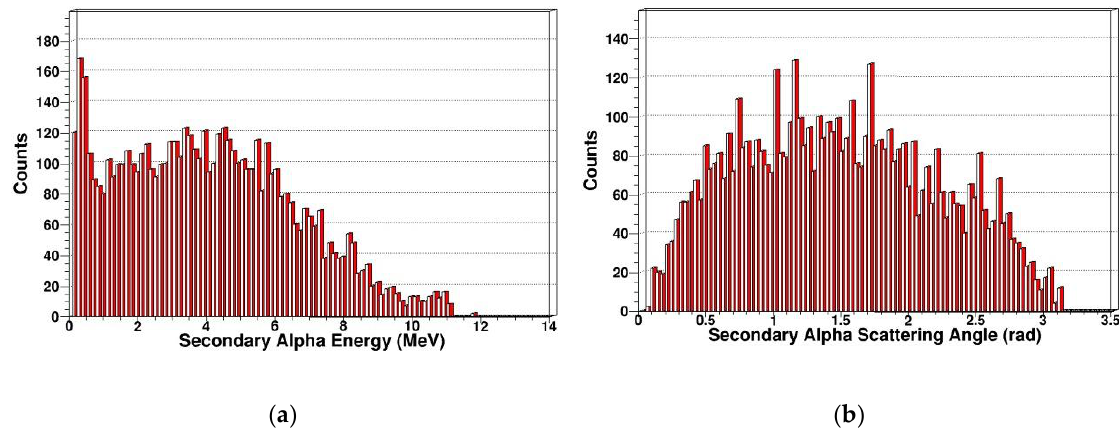
Figure 9. Secondary alphas in SDD generated by neutrons: ( a ) Energy spectrum of secondary alphas; ( b ) scattering angle distribution of secondary alphas.